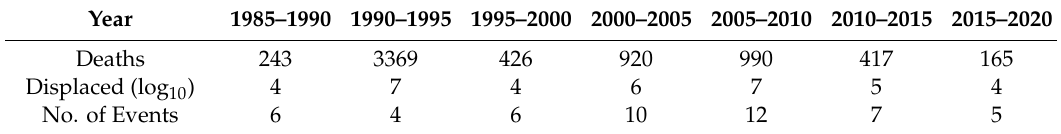
Table 1. Classification of the total number of flood events causing deaths and displacement of people in Nepal from 1985 to 2018. The intervals of 1990–1995 and 2005–2010 are trans-boundary floods which included China, India, and Bhutan as well as Nepal (Source: Dartmouth Flood